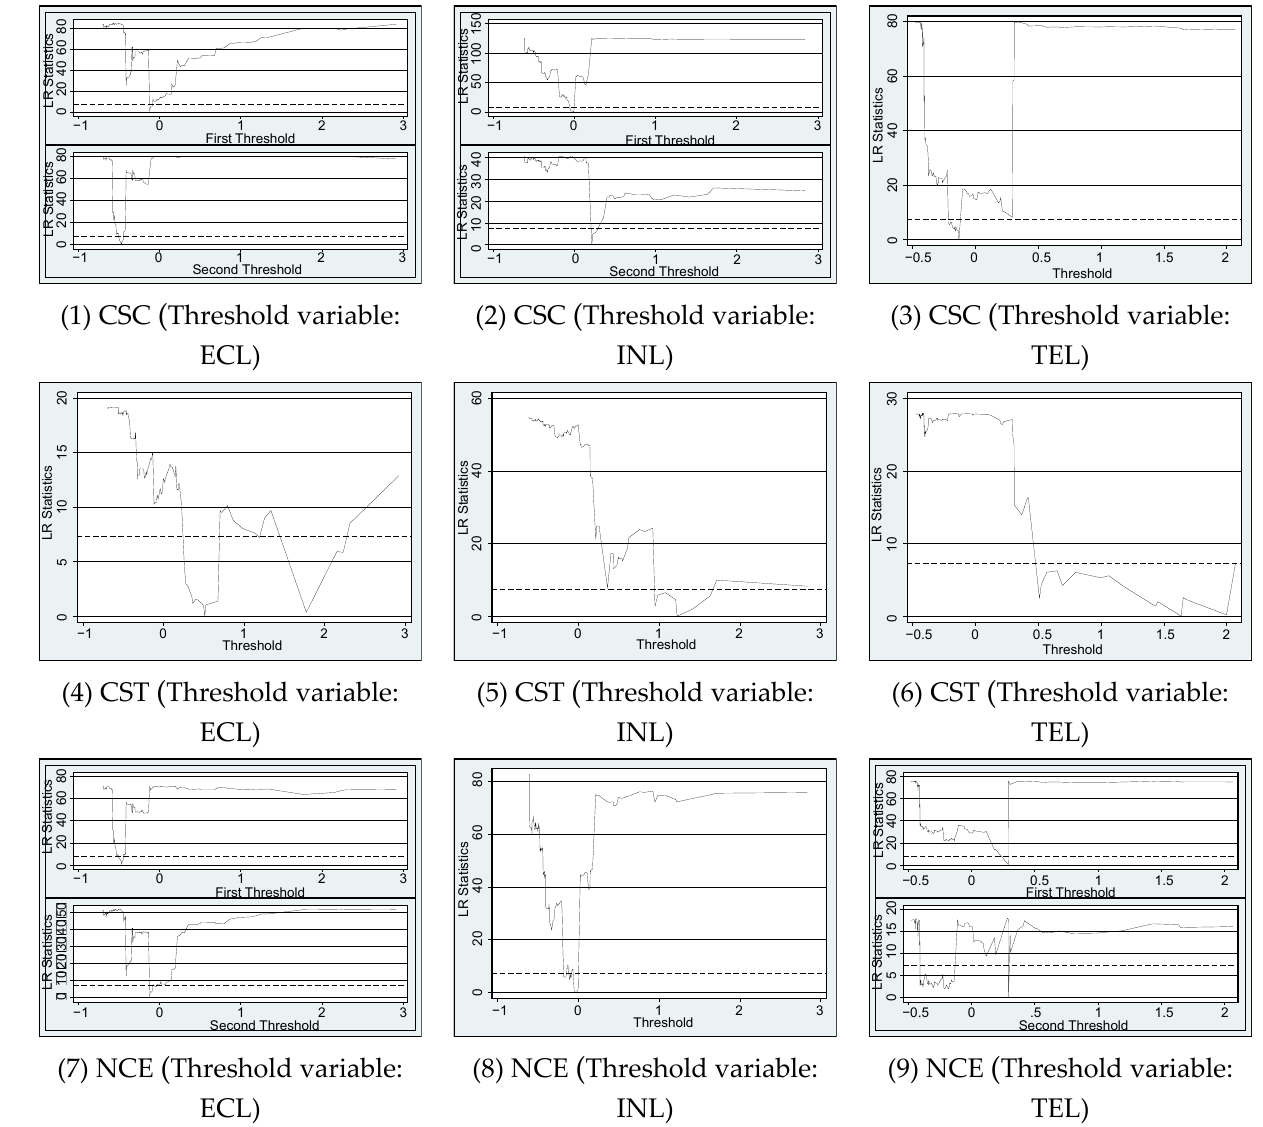
Figure 8. LR test plot of threshold variables.